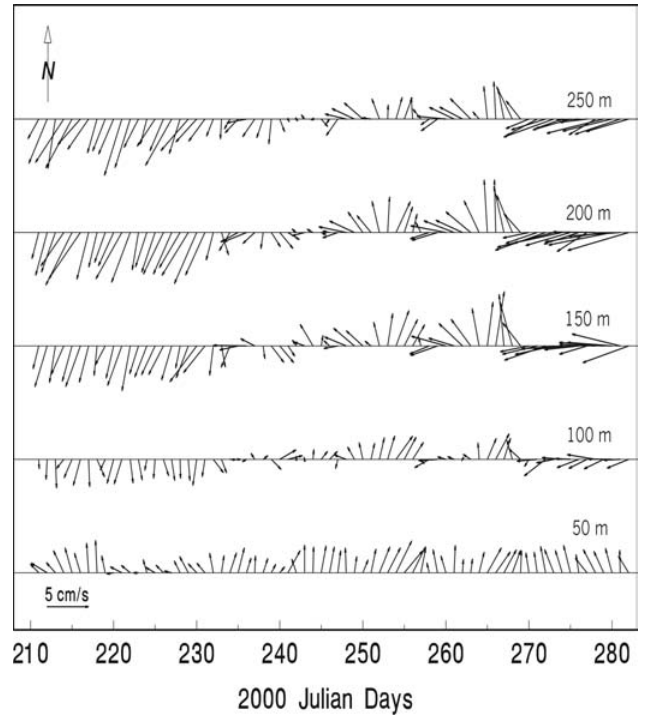
Figure 2. A feather time-series of the mean flow on the five current meters deployed ~1 km south of MEF in 2000. The mean flow depicted is the original hourly record filtered with a low pass Kaiser-Bessel filter with 32 hour cutoff period [Emery and Thomson , 2001]. Vertical patterns are similar in two current meter moorings deployed in 2001, one near this location and one near Salty